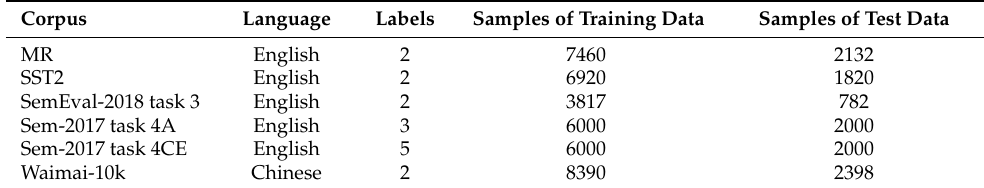
Table 1. The summarization of each